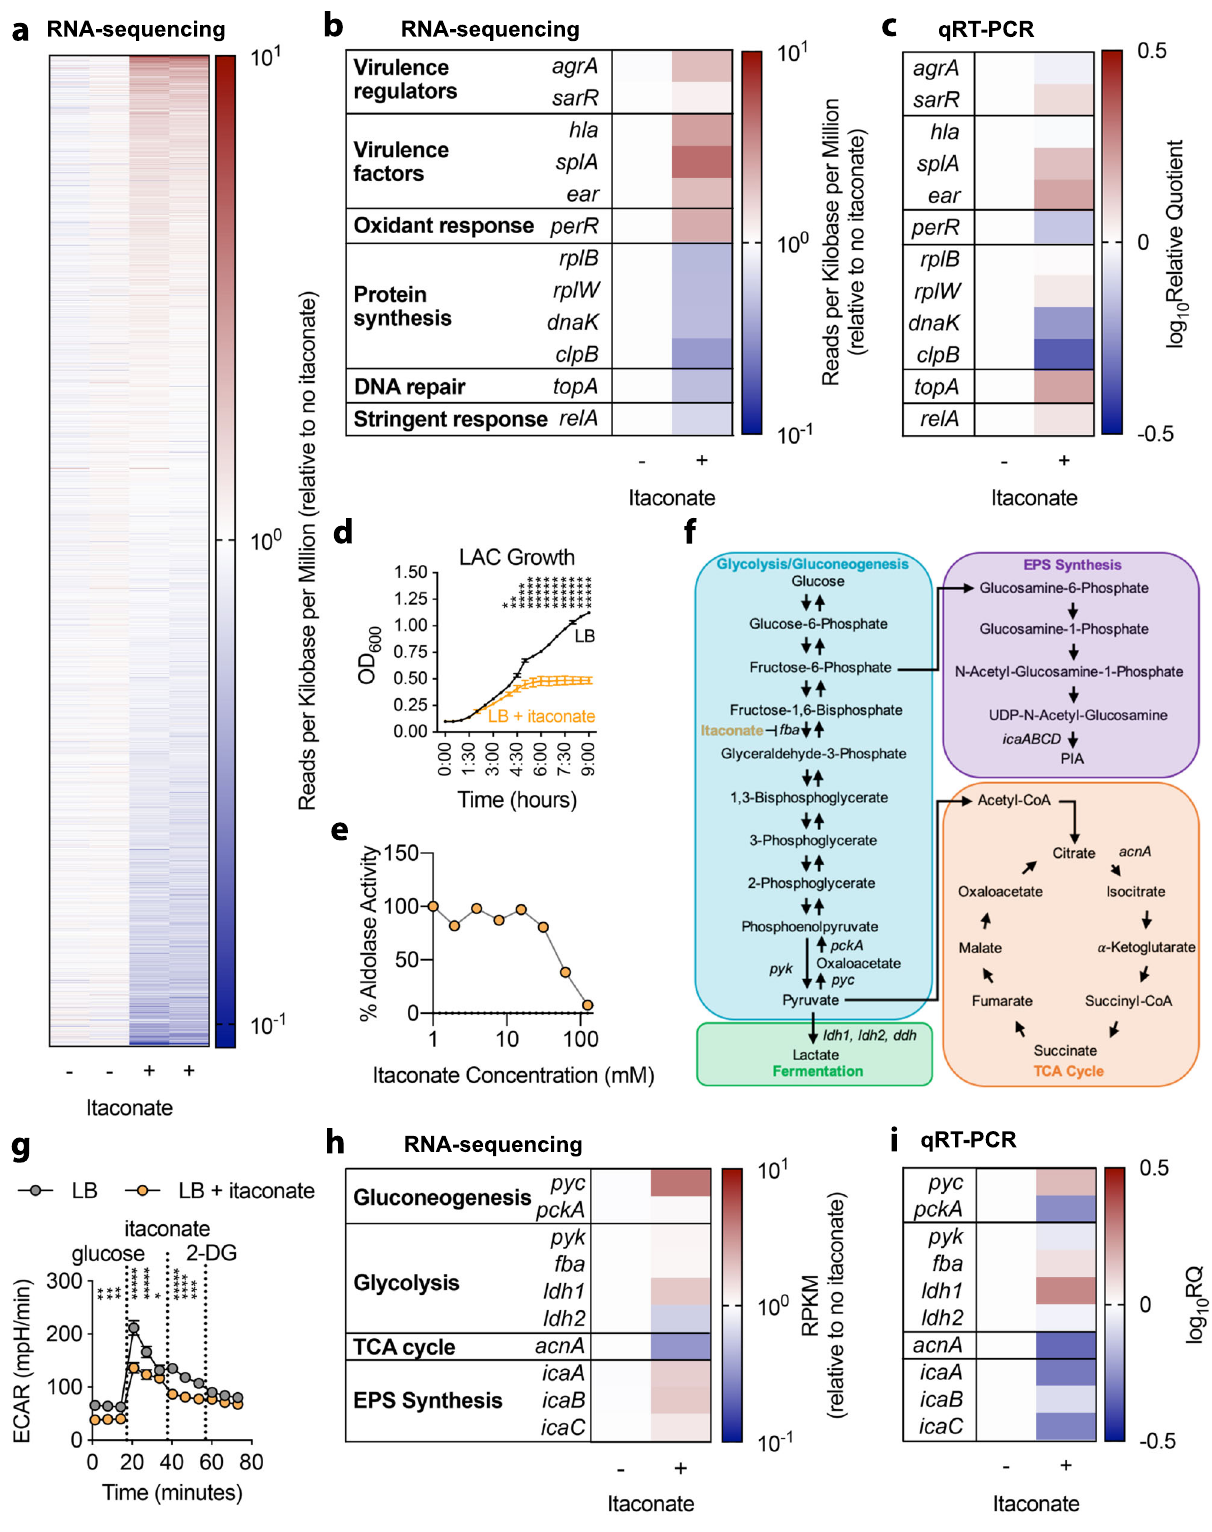
Fig. 3 Itaconate induces S. aureus metabolic stress. a Changes in the S. aureus LAC transcriptome upon exposure to itaconate (30 mM). b , c Stress response gene expression in LAC exposed to itaconate. d LAC growth in the presence of itaconate (30 mM). e Inhibition of LAC aldolase activity by itaconate. f Depiction of S. aureus central carbon metabolism. g Extracellular acidi fi cation rate (ECAR) of LAC grown with or without itaconate (30 mM) for 72 hours . h , i Central carbohydrate metabolism gene expression in LAC exposed to itaconate (30 mM). Data are shown as mean ± SEM from n = 2 biological replicates from one independent experiment ( a , b , e , h ) or 3 biological replicates from 3 independent experiments ( c , d , g , i ). Signi fi cance determined by two-tailed t-student with FDR correction (d, g); * P < 0.05, ** P < 0.01, *** P < 0.001, **** P < 0.0001, ***** P < 0.00001.